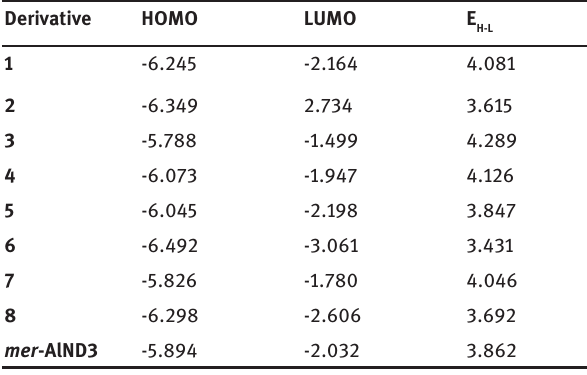
Table 5: Calculated HOMO, LUMO, and gap energies (E eVs) in their excited state (S 31G(D) level.